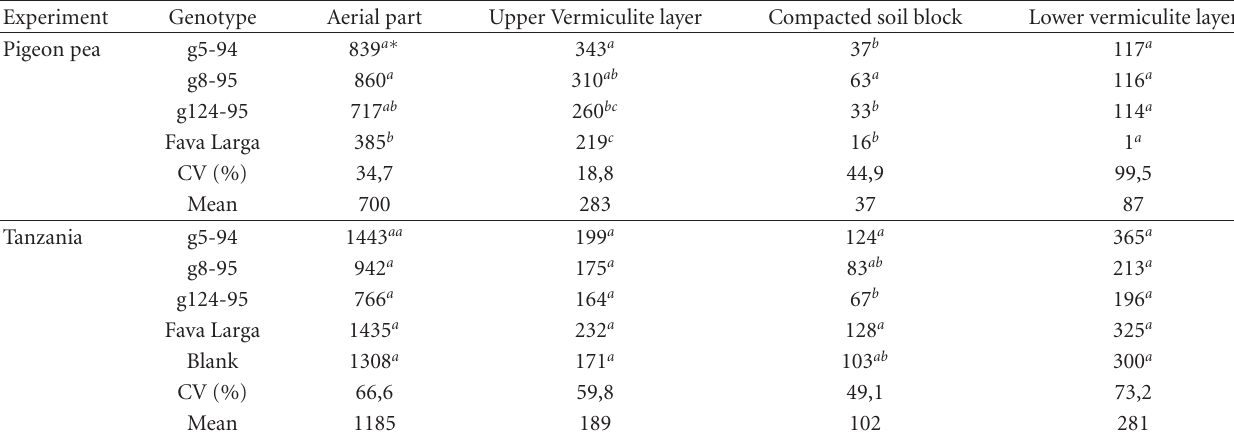
Table 3: Dry matter weights of the aerial part of the plants and of the roots in the upper and lower vermiculite layers and in the compacted soil layer, of pigeon pea plants and of Tanzania grass plants planted after the pigeon pea harvest of experiment 7.